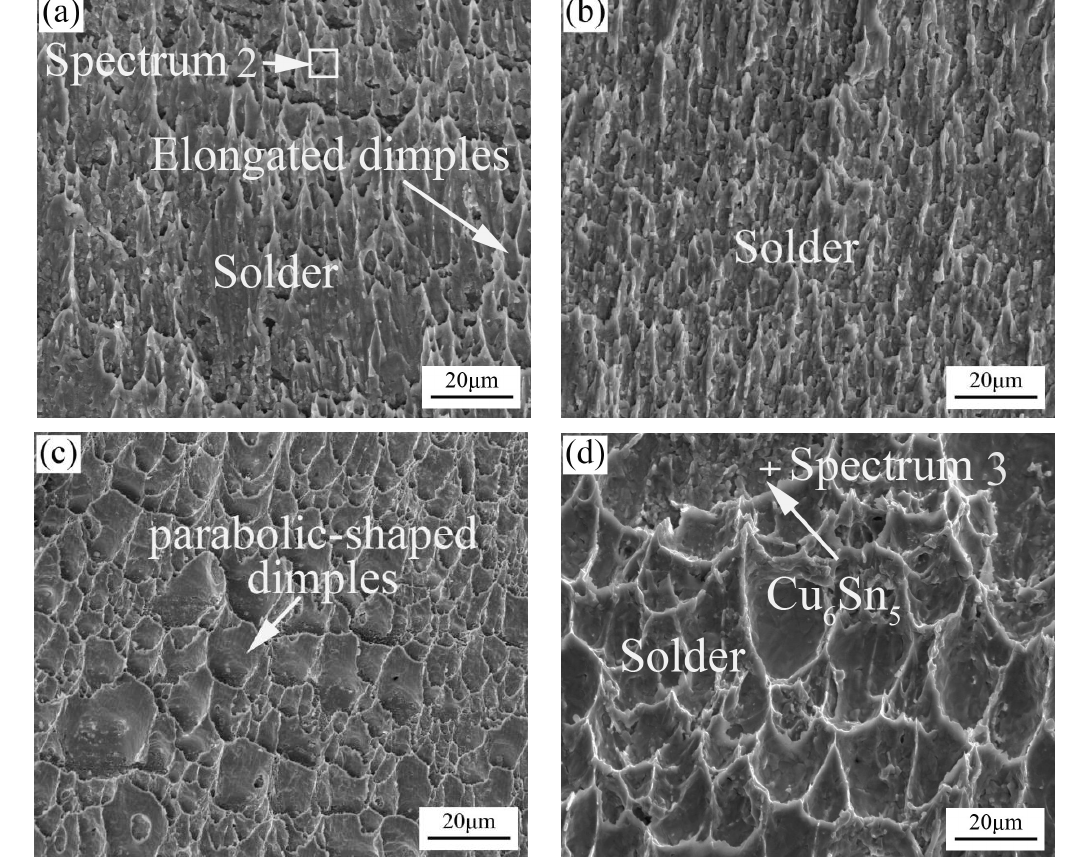
Figure 6. Top views of the shear fracture surfaces for the solder joints at a 400-ms ultrasonic bonding time for different aging times: ( a ) 24 h; ( b ) 120 h; ( c ) 240 h and ( d ) 360 h.